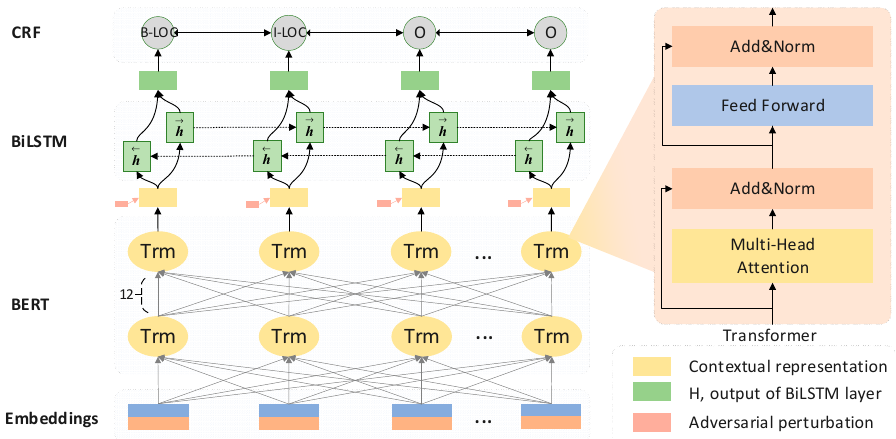
Figure 3. The architecture of the ACE-ADP model for agricultural diseases and pests.